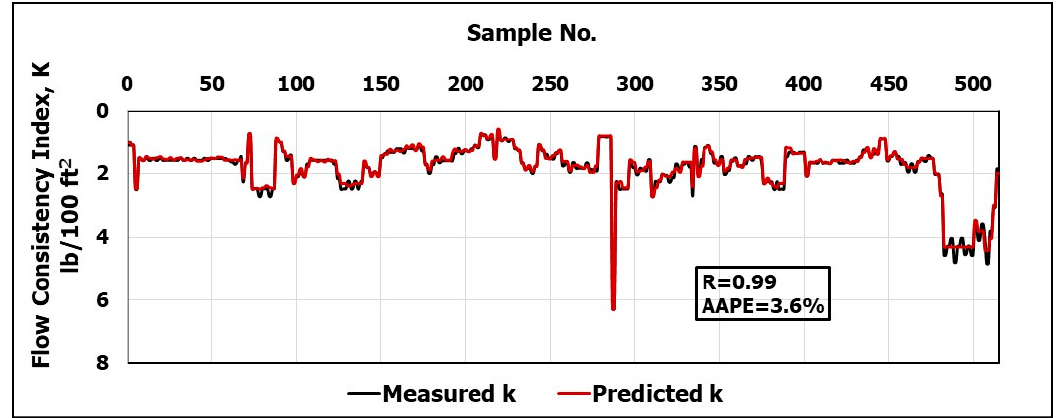
Figure 7. Measured k vs. Predicted k from the ANN model . Table 8. The optimized coefficients for estimating the normalized